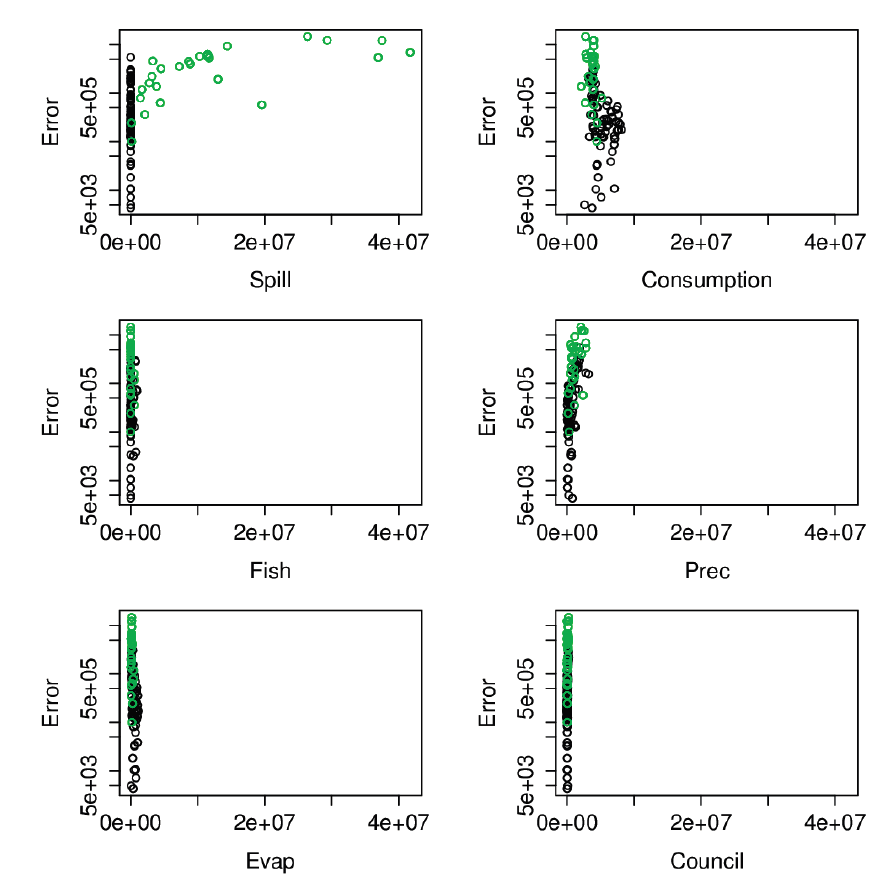
Figure 4. Absolute value of the simulated change in storage minus the observed change in storage (error) versus the monthly spill, consumption, fisheries release, precipitation, evaporation and inputs from council. Values during spill events are shown in